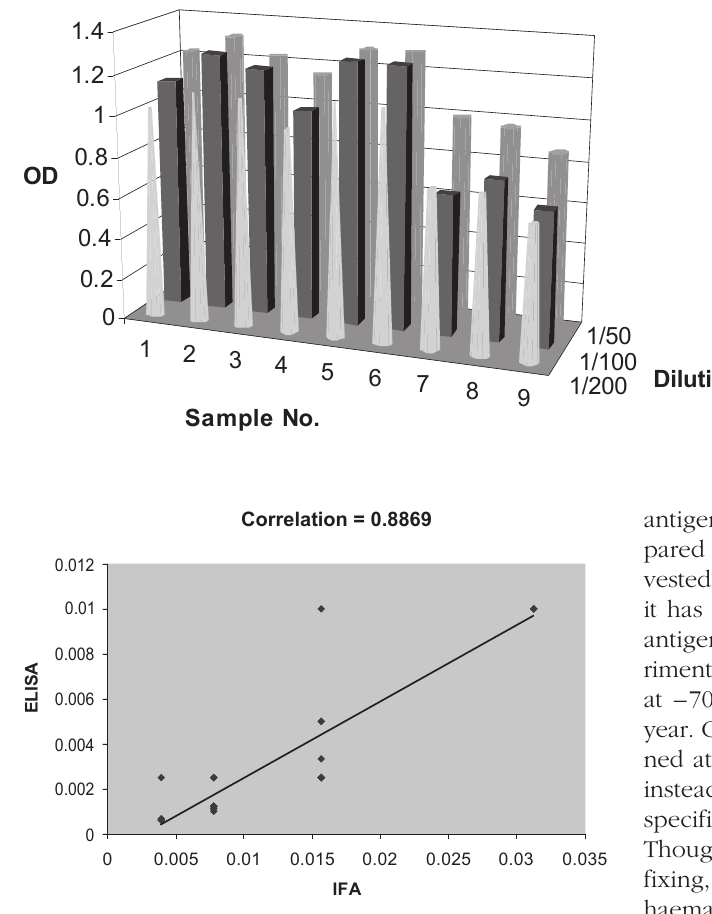
Fig. 2. – Correlation curve between IFA and ELISA.